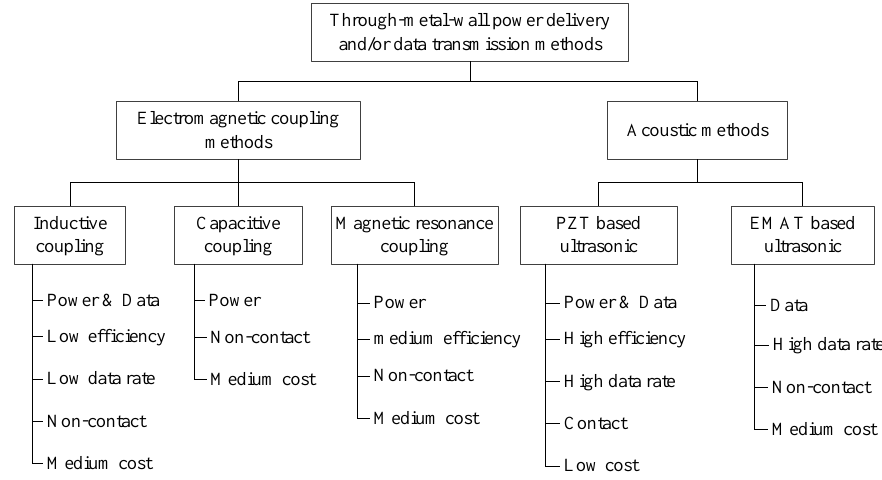
Figure 9. Summary of characteristics of different through-metal-wall power delivery and/or data transmission methods.